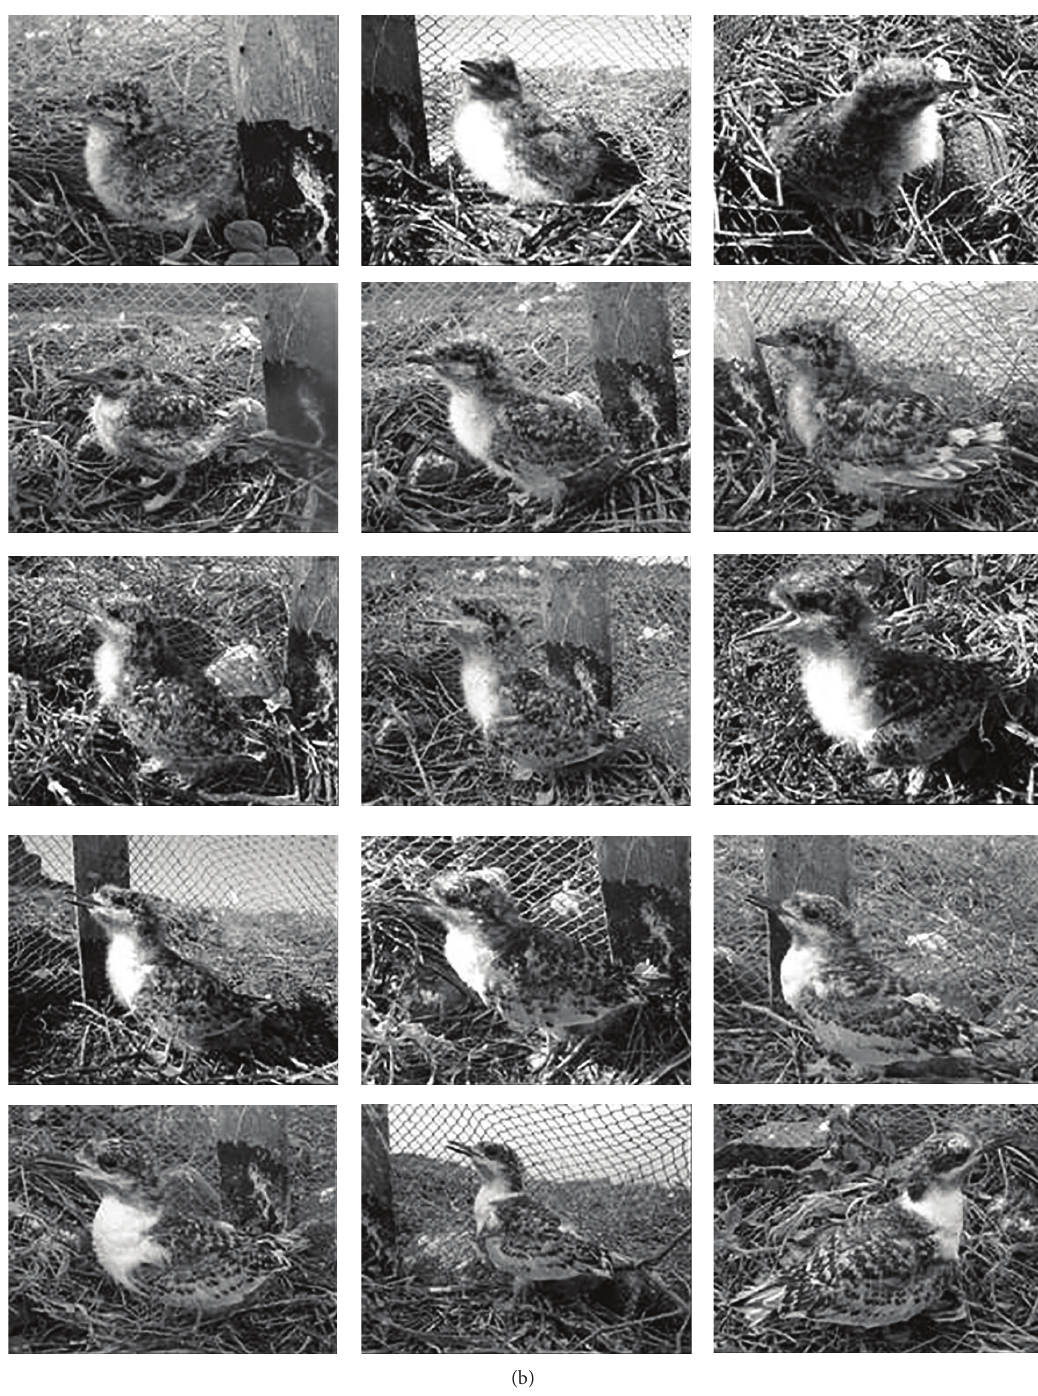
Figure 16: Daily transformation of a Sterna hirundinacea